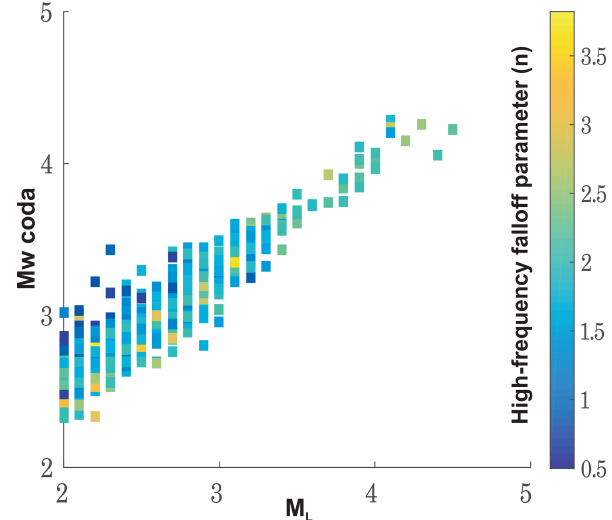
Figure 7. Same scatter plot displayed in Fig. 6. Here the color code indicates the estimated high-frequency falloff parameter for each inverted